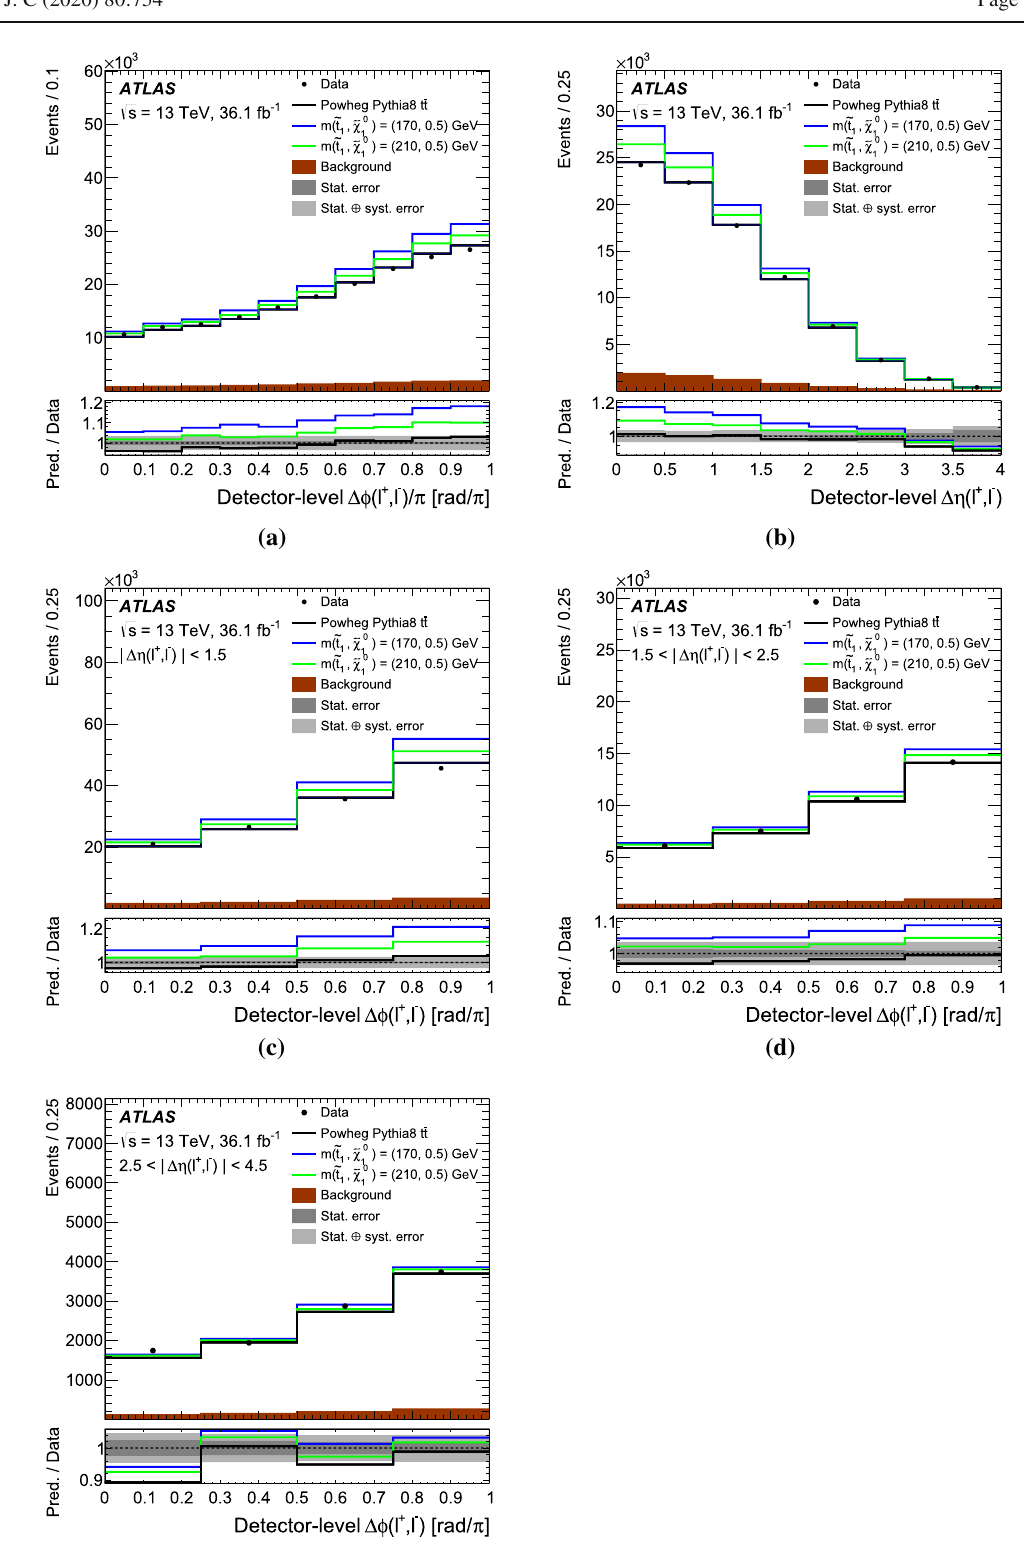
Fig. 15 The inclusive a (cid:3)φ and b (cid:3)η distributions compared to the uncertainty bands represent the statistical and systematic uncertainties = 170GeVand210GeV, added in quadrature. The systematic uncertainties include contributions sumoftheSMandSUSYpredictions,for m ˜ t 1 = 0 . 5GeVaswellasthe (cid:3)φ inregionsof (cid:3)η : c | (cid:3)η | < 1 . 5, d from leptons, jets, missing transverse momentum, background mod- and m ˜ χ 0 1 elling, pile-up modelling and luminosity, but not PDF or t ¯ t modelling 1 . 5 < | (cid:3)η | < 2 . 5, and e 2 . 5 < | (cid:3)η | < 4 . 5. The dark uncertainty bands in the ratio plots represent the statistical uncertainties while the light